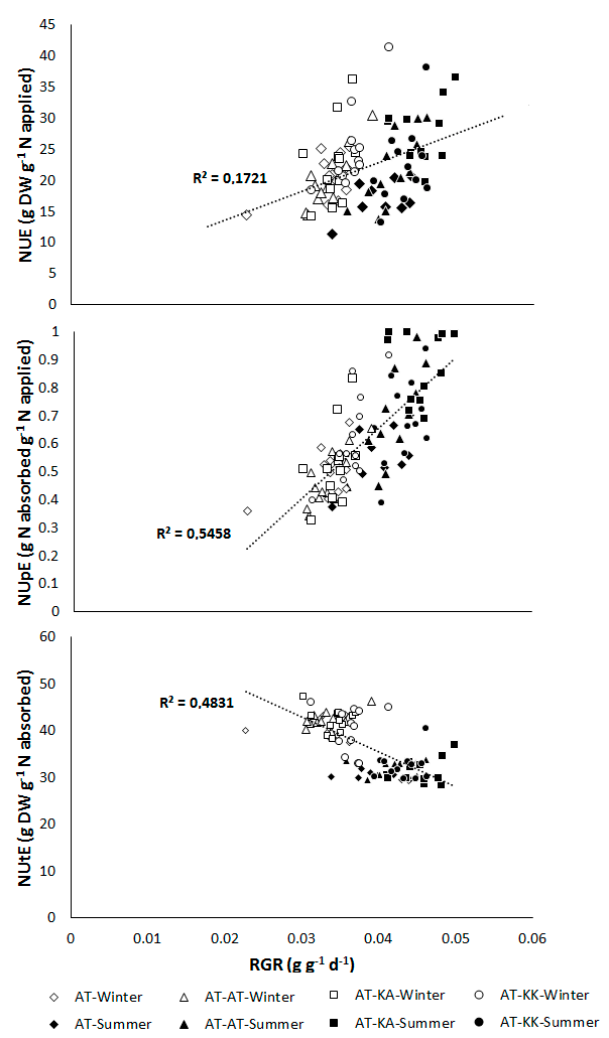
Figure 4. Relationship between nitrogen-use (NUE; top), -uptake (NUpE; middle), and, -utilization efficiency (NUtE; bottom) to the relative growth rate (RGR) in plants at the reproductive stage grown under greenhouse during summer or winter seasons. Open symbols represent measurements from the winter experiment, and solid symbols denote measurements from the summer experiment for each grafting treatment.